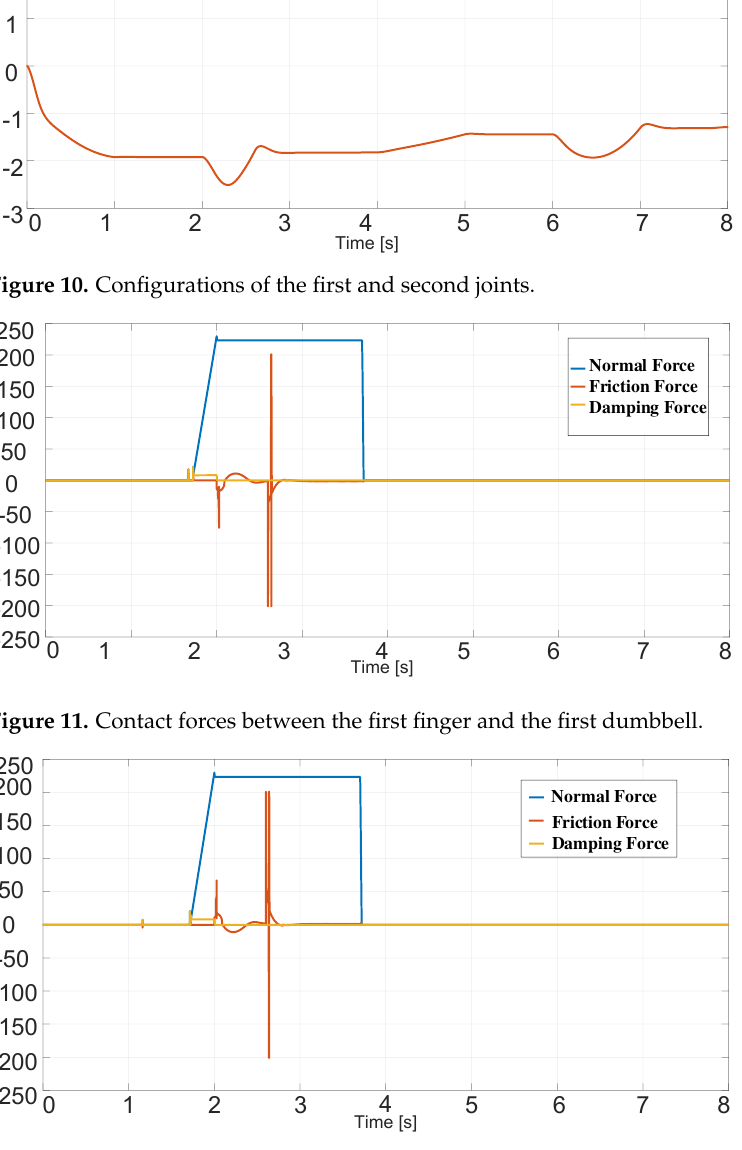
Figure 12. Contact forces between the second finger and the first